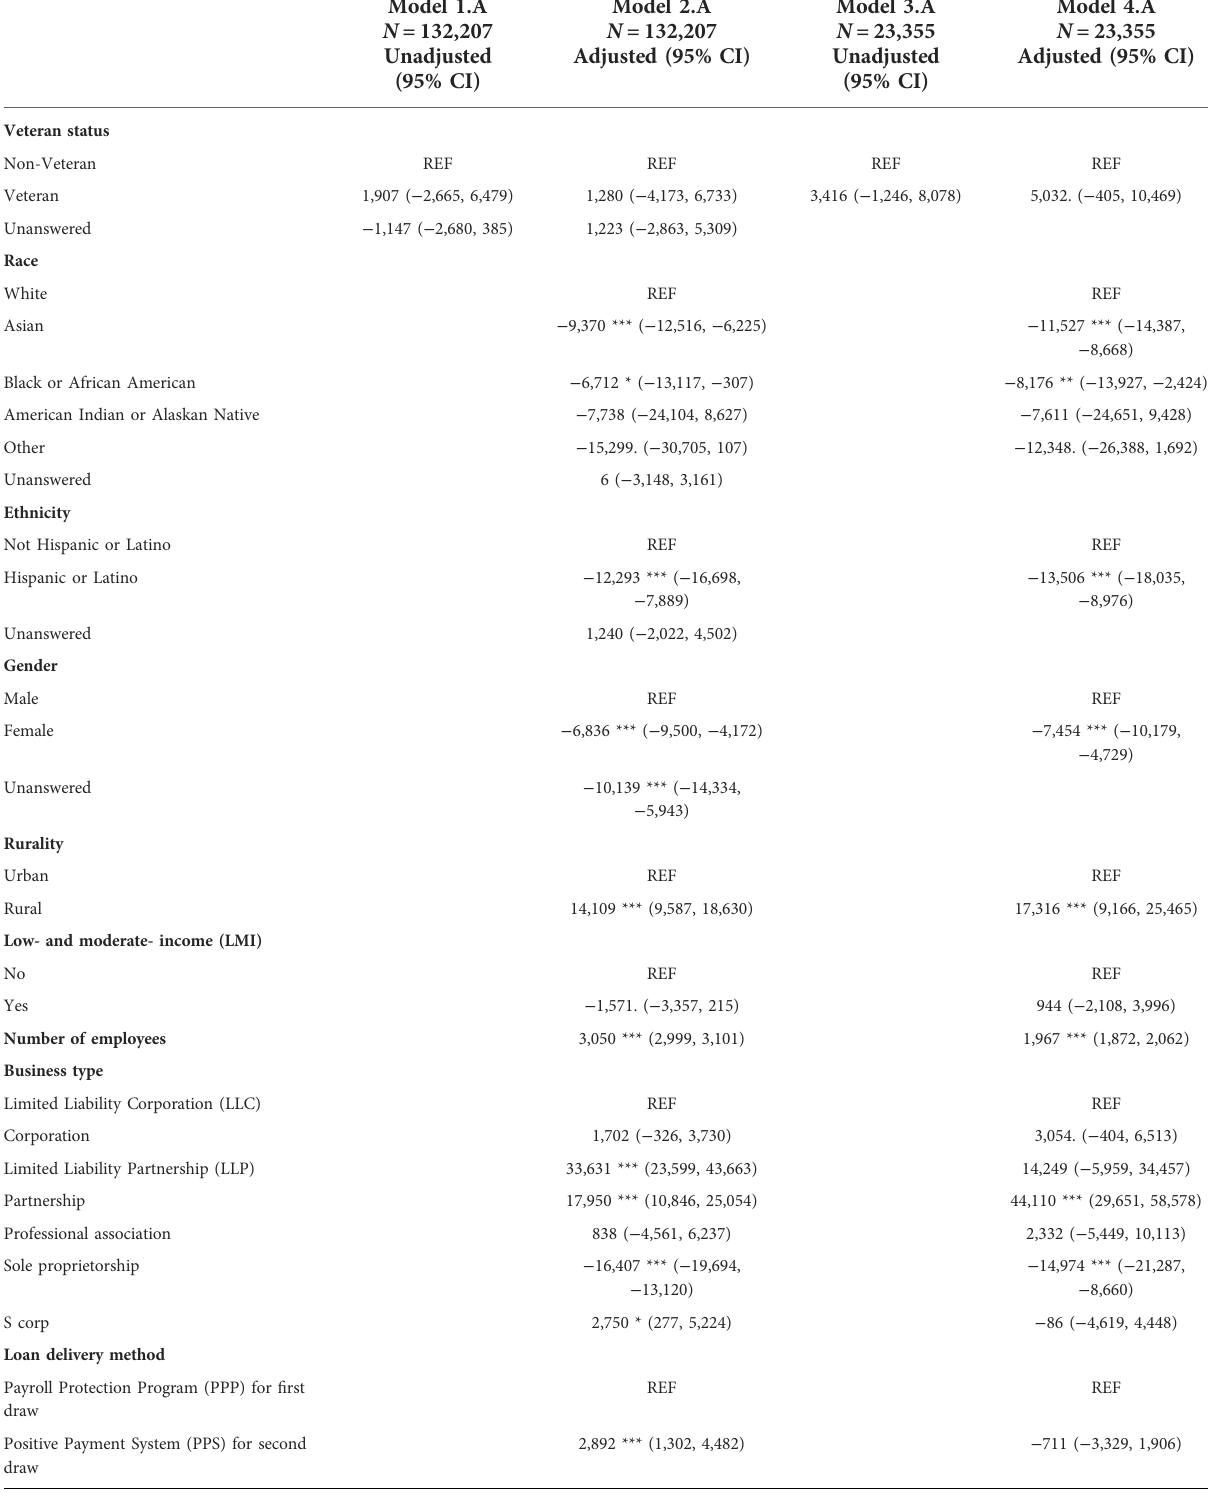
TABLE 3 Associations between payroll protection program (PPP) loan approval amount and veteran status and other